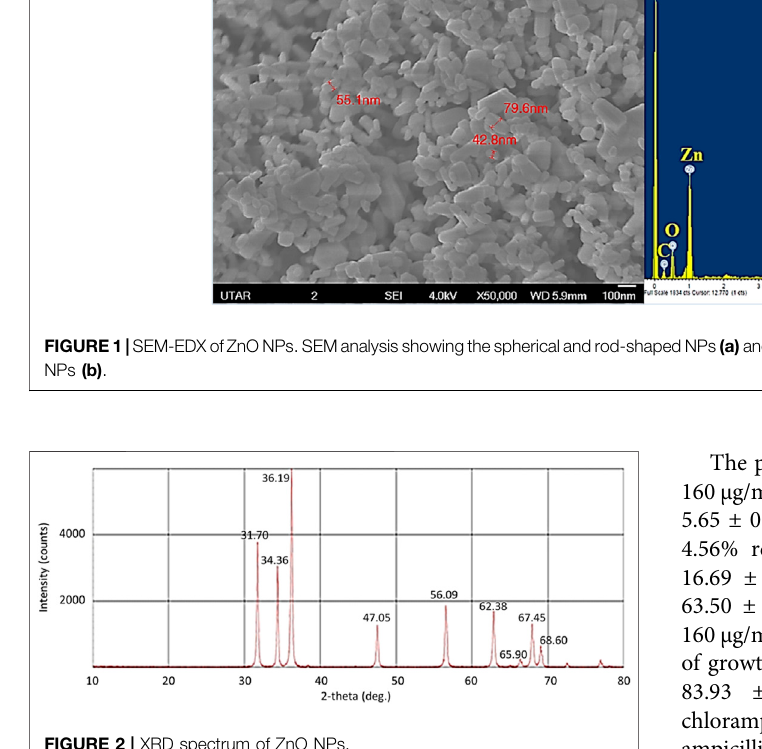
FIGURE 2 | XRD spectrum of ZnO NPs.